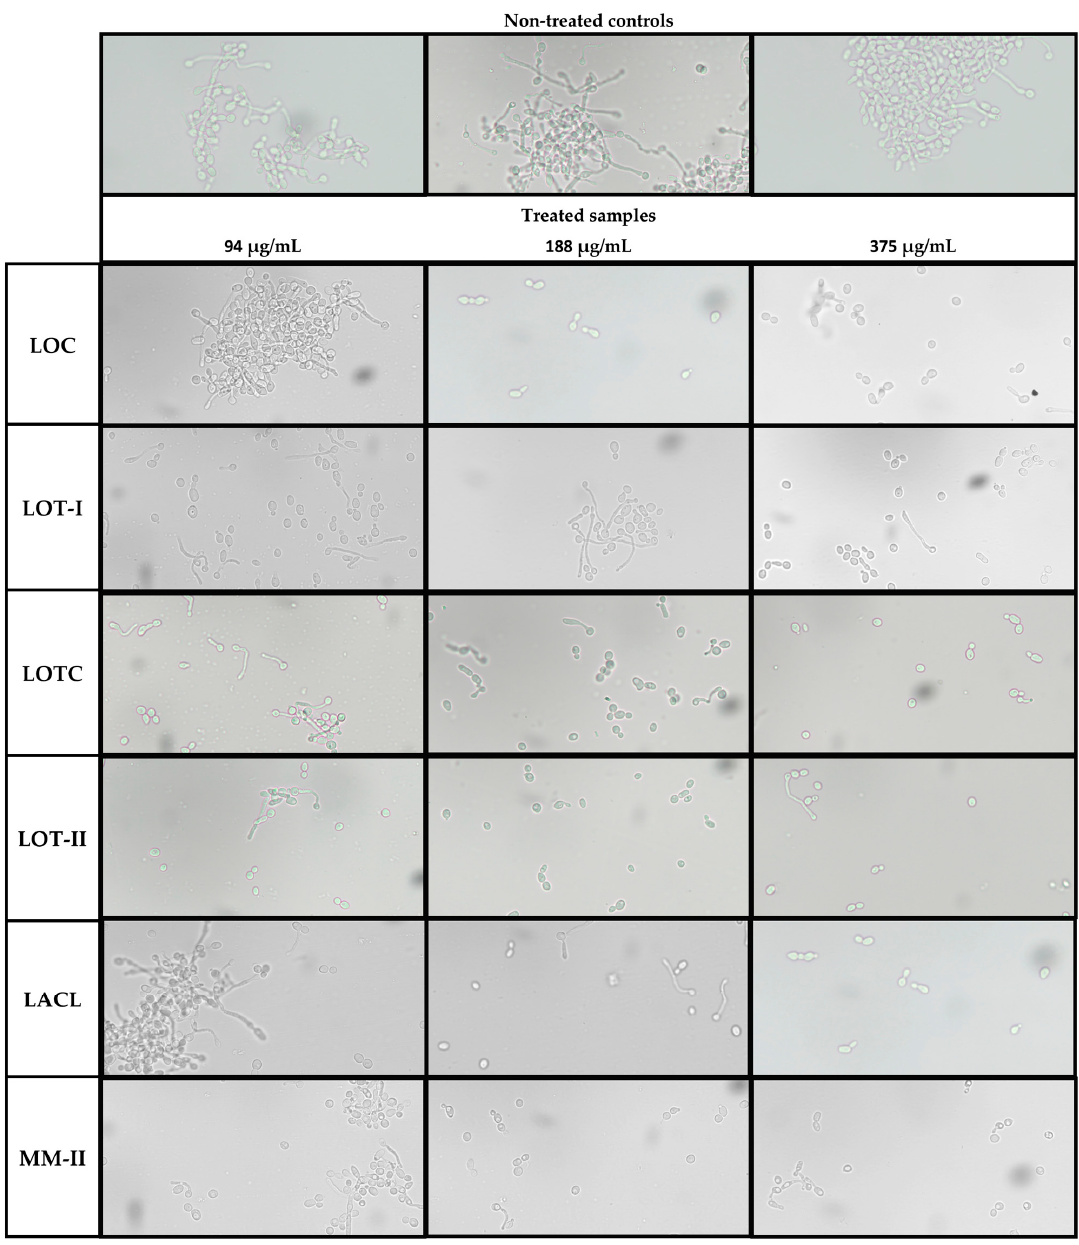
Figure 4. E ff ects of LOC, LOT-I, LOTC, LOT-II, LACL and MM-II on hyphal growth of C. albicans in liquid media. Yeasts were grown in RPMI 1640 medium with 10% SFB and photographed at 40 × magni fi cation after 6 h incubation.